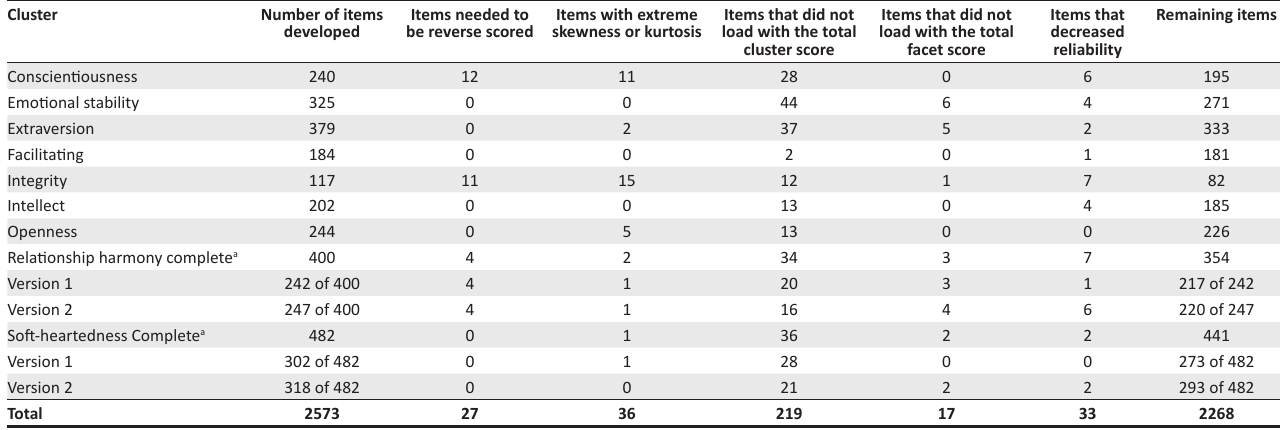
TABLE 4: Psychometric properties of the South African Personality Inventory items. Cluster